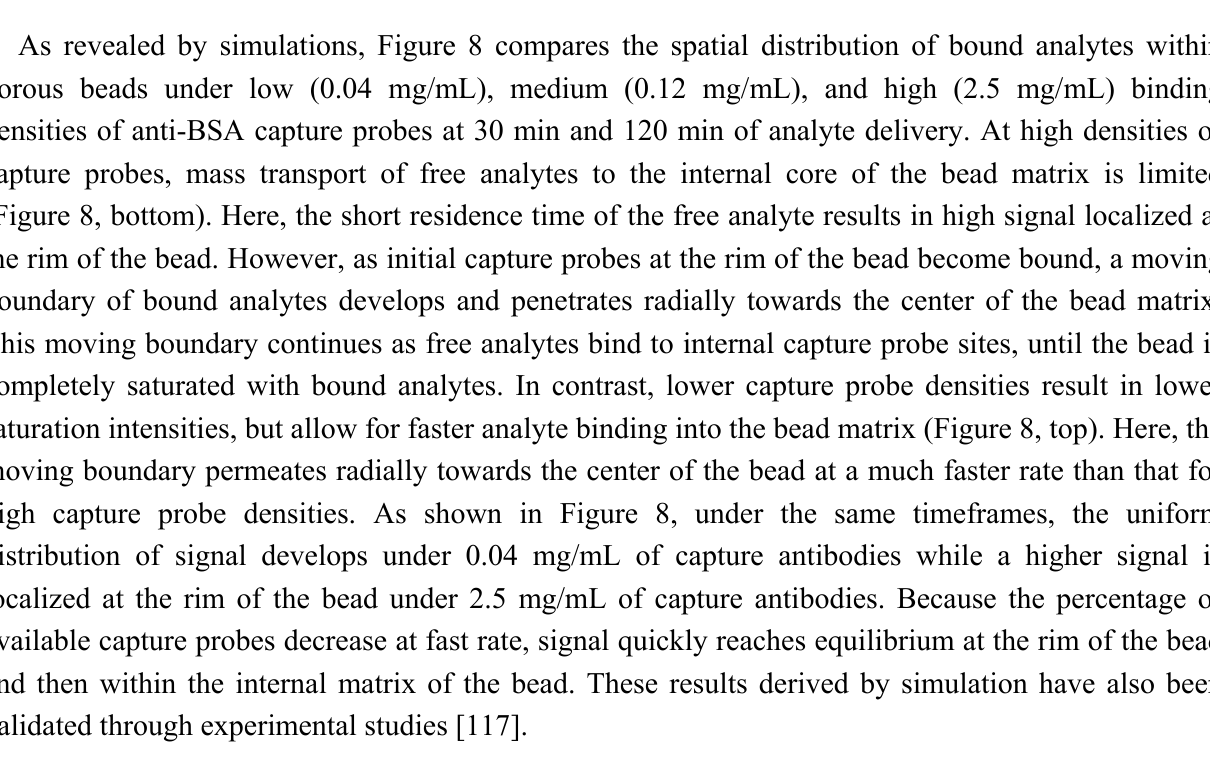
Figure 8. Spatial distribution of fluorescently-labeled BSA, as a function of microbead receptor concentration and time, as predicted by finite element analysis, at the diametral plane of the microbead under different binding